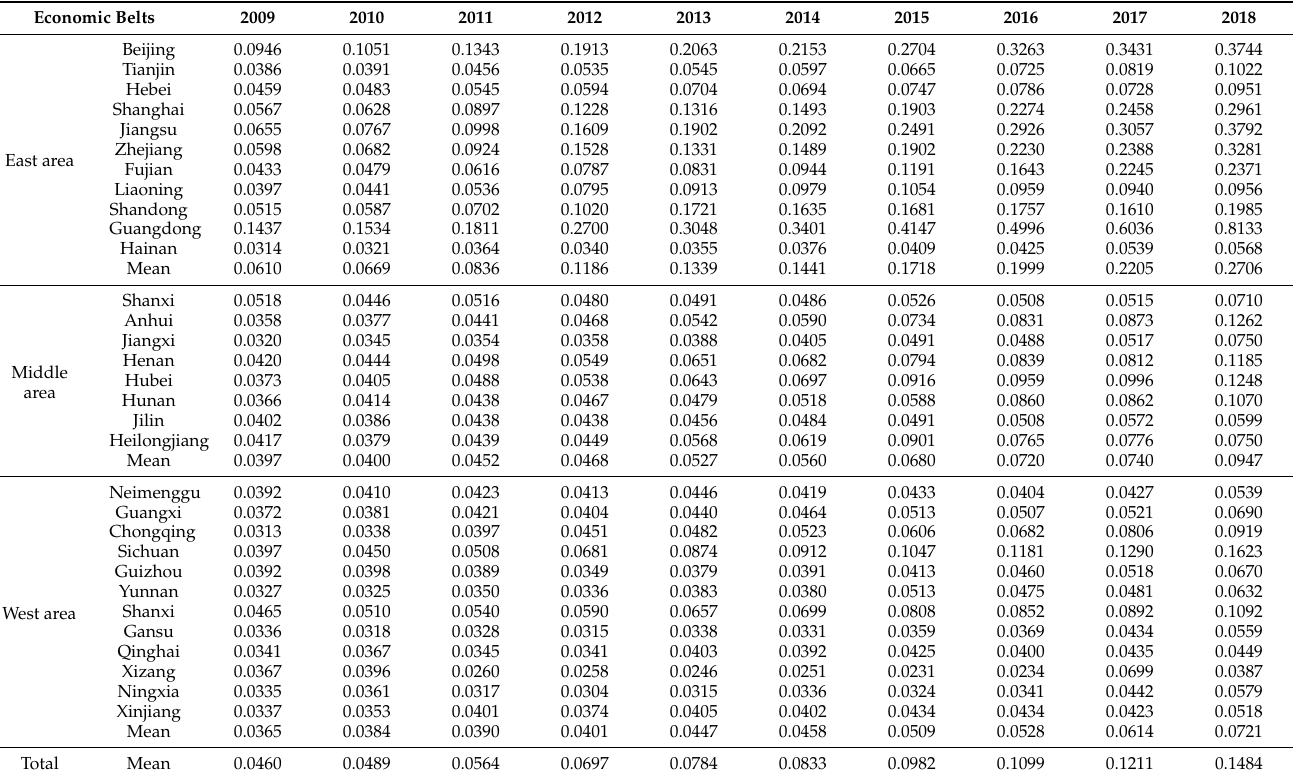
Table A2. China’s digital economy development level for the 31 provinces from 2009 to